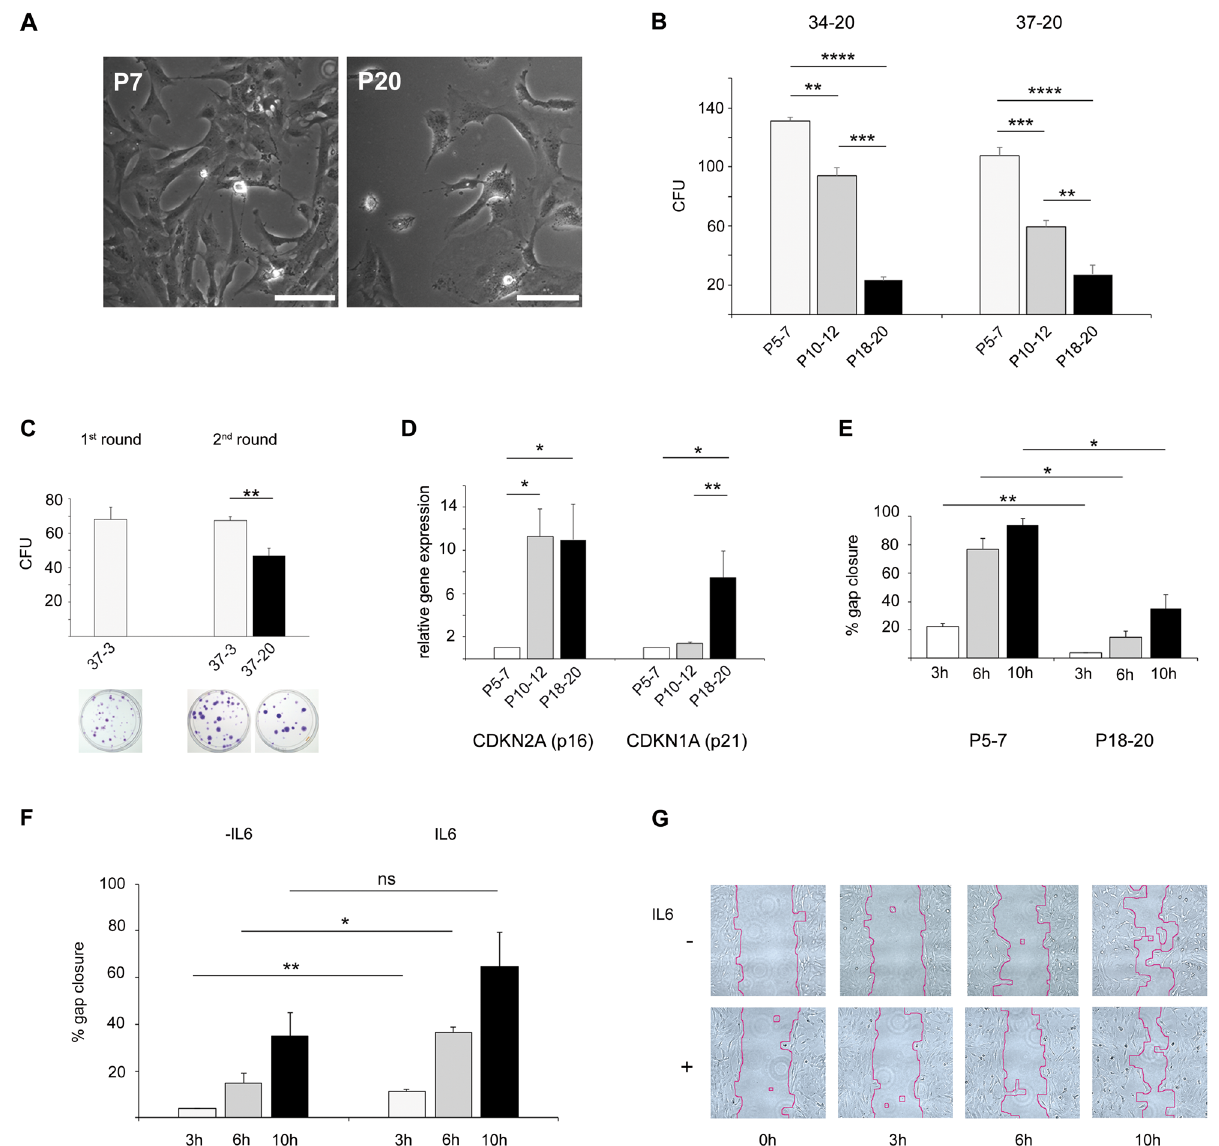
Figure 6. Effects of long-term culture on hFOB stemness and migratory behavior. ( A ) Brightfield microscopy (magnification × 200, scale bar 100 µm) of hFOB cells passage 7 and 20. ( B ) CFU-F of hFOB cells of passages 5–7, 10–12 and 18–20 were performed in triplicates at the given environmental settings. Cells were seeded at a density of 10 cells/cm 2 (600 cells/plate) and incubated for 15 days. Cells were stained with Crystal violet. Mean number ± standard deviation (SD) of resulting colony-forming units fibroblasts (CFU-F) was determined. ( C ) Colony formation (2nd round) using cells derived from a previously formed colony (1st round) was performed in triplicate at the given temperature and oxygen tension. Cells were seeded at a density of 10 cells/cm 2 (600 cells/plate) and incubated for 15 days. After the 1st round, cells were trypsinized and seeded again for a 2nd term of colony formation (density of 10 cells/cm 2 ). ( D ) mRNA levels within hFOB cells at passage 10–12 or passage 18–20 encoding CDKN2A (p16) and CDKN1A (p21) were measured by RT-qPCR, normalized to YWHAZ and plotted as fold induction relative to the levels of hFOB P5-7. ( E ) Migratory behavior of passage 5–7 and passage 18–20 cells at 34 °C 20% O 2 . Determination of %-gap closure after 3 h, 6 h and 10 h. ( F ) Migration of hFOB passage 18–20 in the presence of IL-6 (10 ng/ml) and without IL-6 (CTR). Determination of %-gap closure after 3 h, 6 h and 10 h. ( G ) Representative images of the gap closure quantified in ( F ) after 0, 3, 6 and 10 h post IL-6